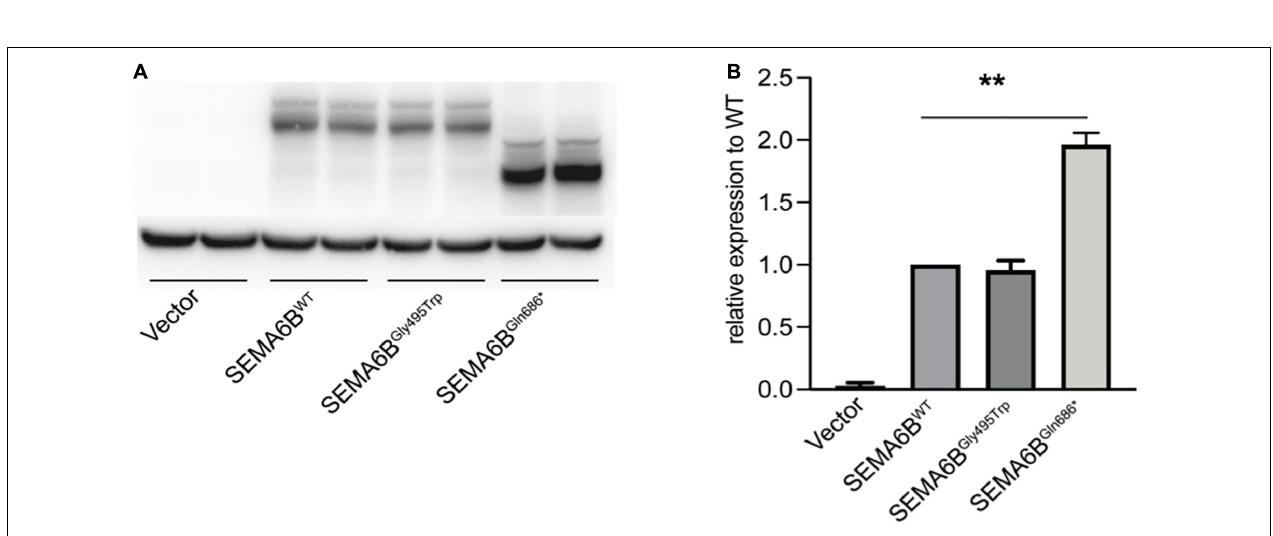
FIGURE 3 | Protein expression of wild type and mutant SEMA6B. (A) SEMA6B Gln686 ∗ demonstrated a shorter protein and remarkably increased expression compared to wild type. (B) Densitometric analysis of SEMA6B. Values were normalized using actin. Three independent experiments were performed for each condition ( N = 3, ** P <